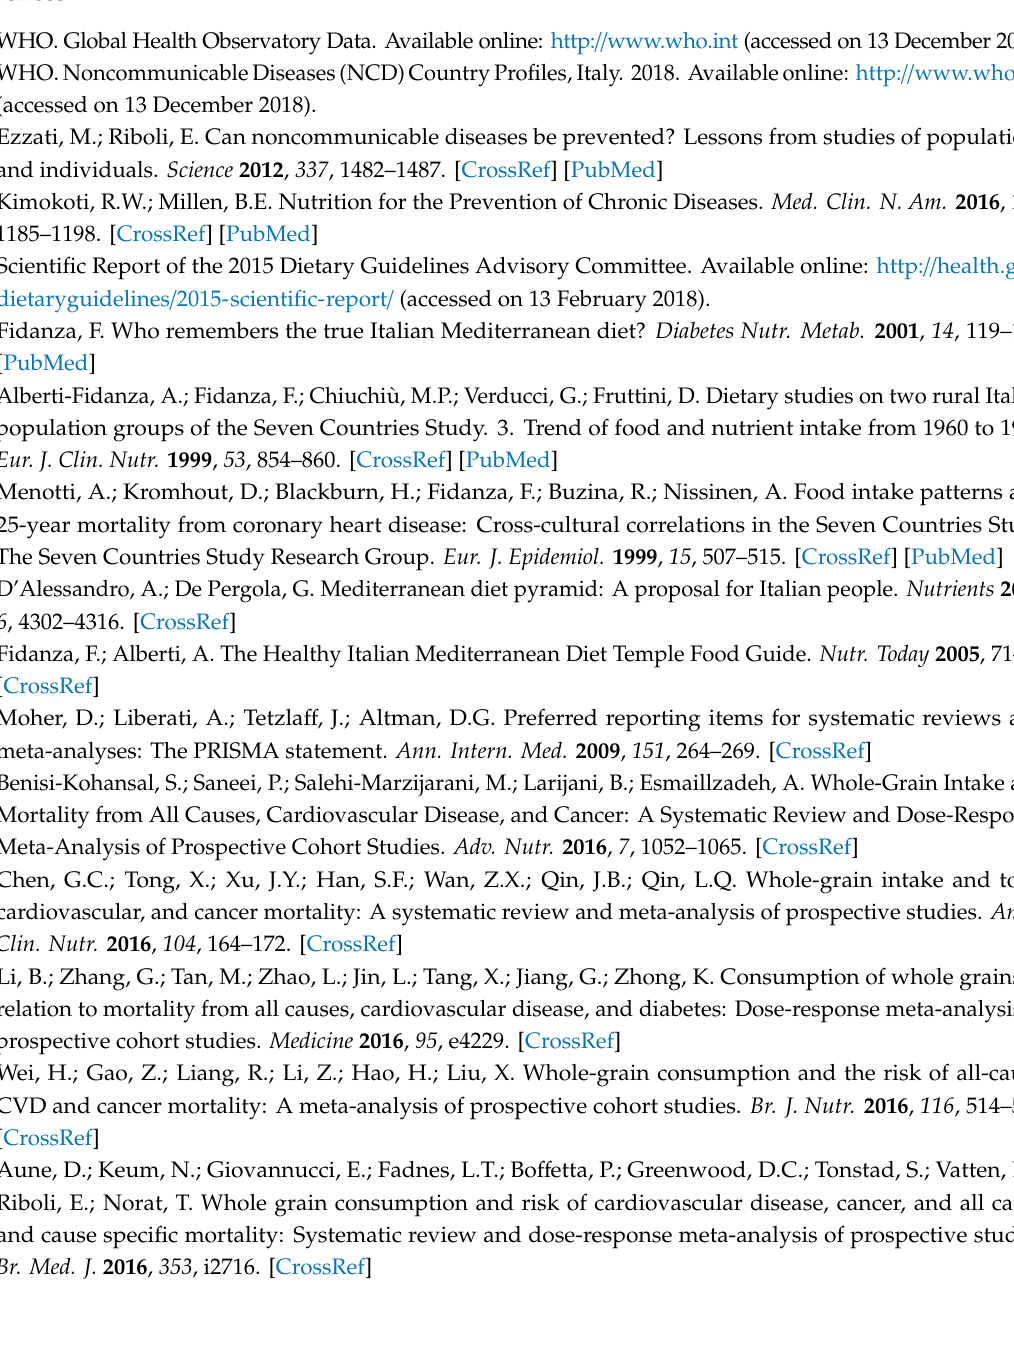
Table S1: Weekly menu plan based on advice of Mediterranean Diet Pyramid for Italian